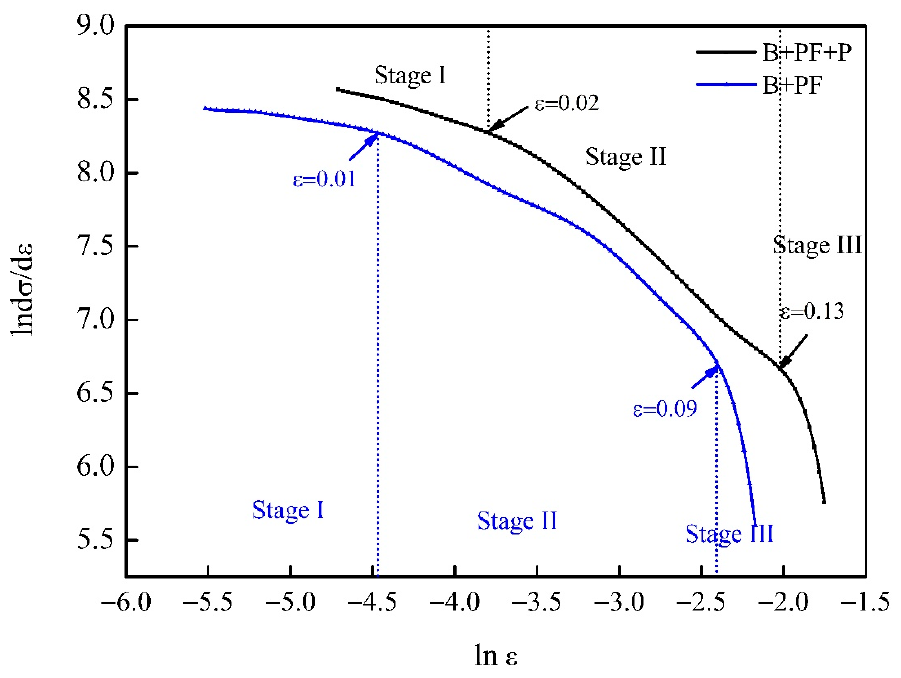
ε ) for dual-phase and triple-phase sample. Figure 7. D C-J plots of ln ( d σ /d ε ) versus ln (